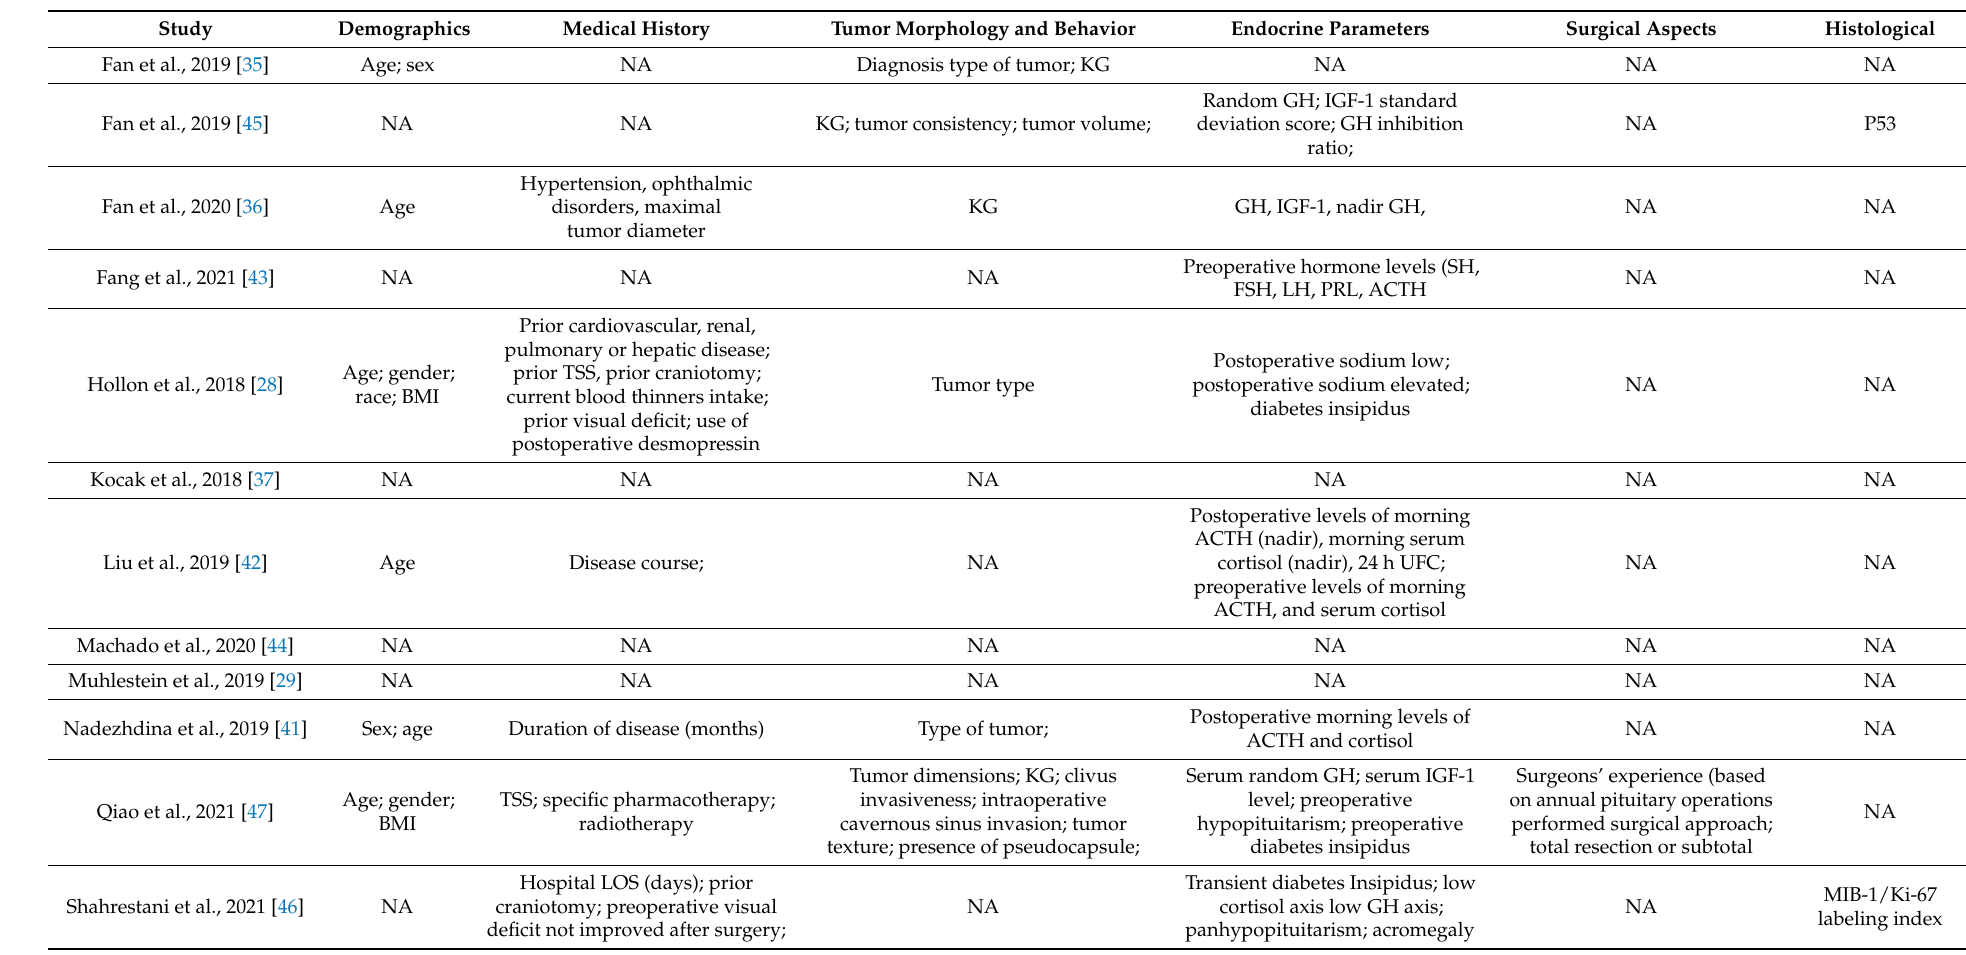
Table 5. Tabulated data utilized as input into the ML